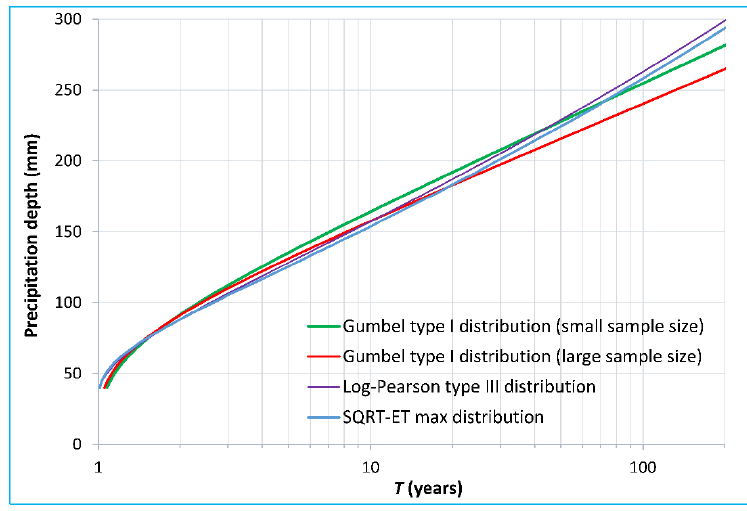
Figure 6. Precipitation depth against return period for the probability distribution functions.